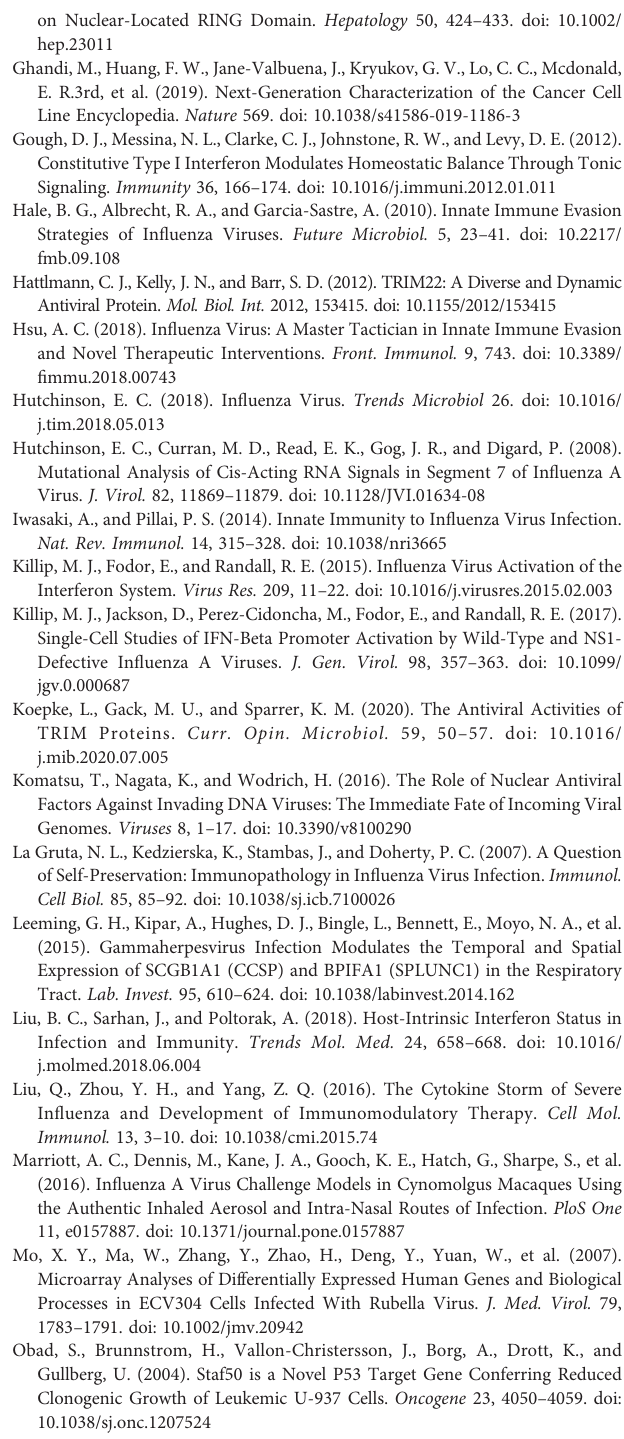
Supplementary Table 5 | Custom IAV primer-probe sequences. Nucleotide sequences for custom IAV ( NP , M1 , NS1 / NEP ) primer-probes mixes used in the